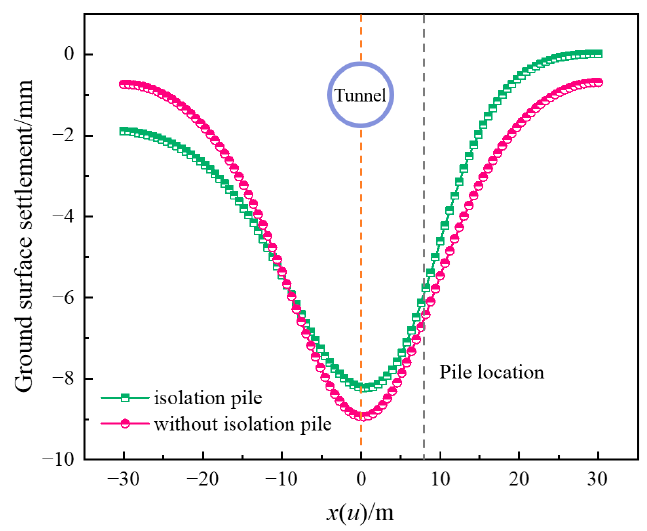
Figure 8. Results of FDM-DEM Coupling.